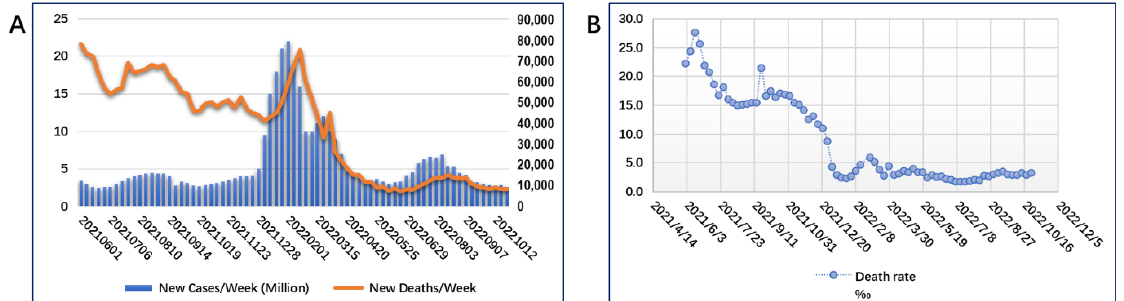
Figure 2. Infections and deaths since June 2021 to October 2022. Infections of SARS-CoV-2 sharply increased and deaths rate has been gradually declining in the early 2022 since Omicron variant became the predominant epidemic variant. ( A ), The weekly number of new cases and new deaths worldwide (from June 2021 to October 2022) released by the WHO. ( B ) Global death rates due to COVID-19 infection (ratio of deaths to infections) from June 2021 to October